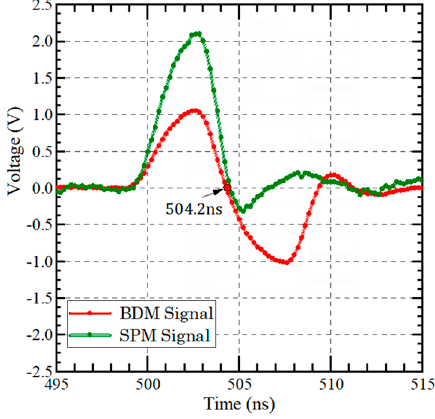
7 of 12 Figure 6. The experimental setup to measure the laser signal: ( a ) based on BDM and ( b ) based on SPM. The laser (VLSS-1064-M-PL, CONNET, Jinan, China) is set in internal trigger mode with a pulse width of 3 ns, a re-frequency of 1000 kHz, and a peak output power of 100 mW. As shown in Figure 6a, the laser emi tt ed from the laser is coupled into the fi ber cou- pler with a 50:50 spli tt ing ratio after passing through the fi ber extension and the electri- cally adjustable fi ber a tt enuator (YXVOA-1064sm-MVOA-0-FA, Yixun Photon, Mianyang, China). At the same time, the background noise provided by the halogen lamp is also cou- pled to the fi ber coupler. Then, the mixed laser signal and background noise are coupled